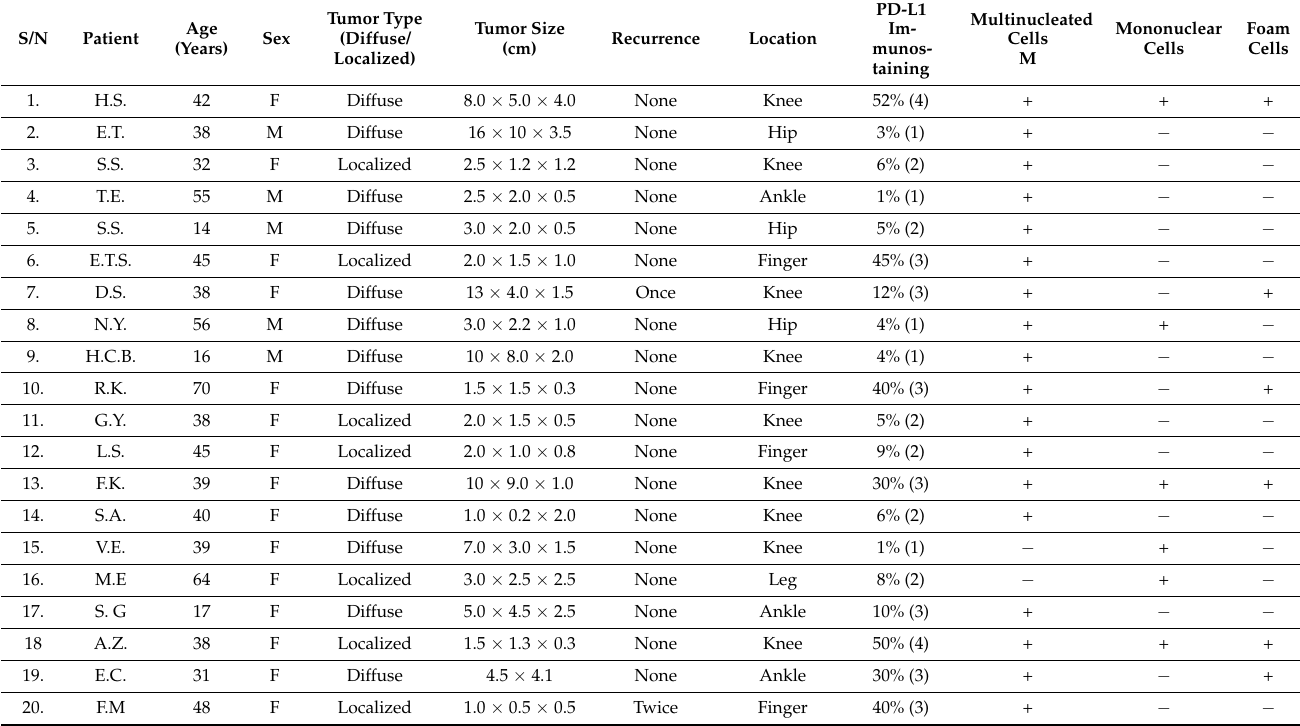
Table 1. Tumor characteristics.